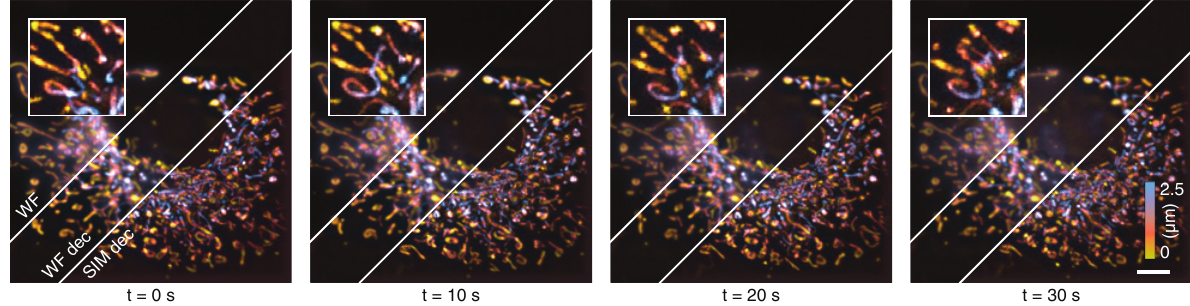
Figure 3: Time series of SR-SIM imaging data following mitochondrial dynamics (stained with MitoTracker Orange) in COS-7 cells, colour- coded maximum intensity z -projection of the deconvolved and SIM reconstructed eight planes (Figure 2). The full series contains 74 time points, each acquired with 50-millisecond SR-SIM acquisition time to allow for motion artefact–free imaging (see Supplementary Material: Visualization 1). The series has been renormalized in brightness to compensate for photo bleaching, but no further processing beyond a standard SIM reconstruction had to be performed. Insets (field of view 7 × 7 μ m 2 ) show deconvolved SIM exhibiting high spatial motility of the mitochondria during the imaging. Scale bar 5 μ